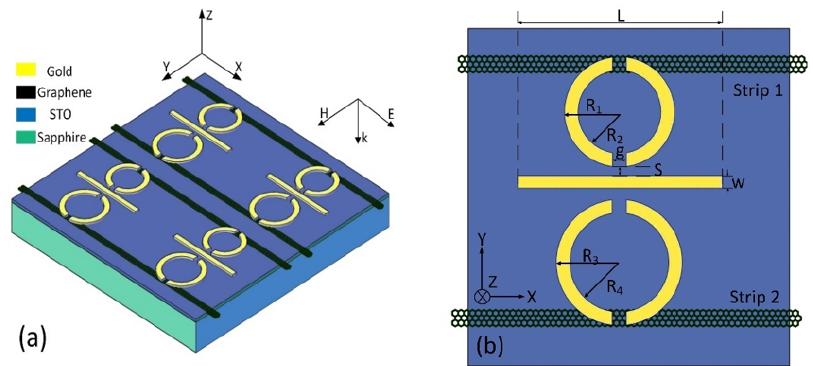
Figure 1b. Two sets of symmetrical half-rings named upper double symmetric semiring resonators (UDSSRs) and bottom double symmetric semiring resonators (BDSSRs) are placed on the upper and bottom sides of cut wire (CW), respectively. The thickness of the metal structure is 0.2 µ m. The length of CW is L = 80 µ m, and the width is w = 5 µ m. For UDSSRs and BDSSRs, the gap width of splits is g = 5 µ m. The outer radius and inner radius of UDSSR are 20 µ m and 15 µ m, respectively. The outer radius and inner radius of BDSSRs are 23 µ m and 18 µ m, respectively. The distance between two DSSRs and CW is S = 3.5 µ m. Under the UDSSRs and BDSSRs, there are two graphene strips defined as strip 1 and strip 2, respectively. The STO film with a thickness of 100 nm is placed between the P x = P y = 120 µ m.